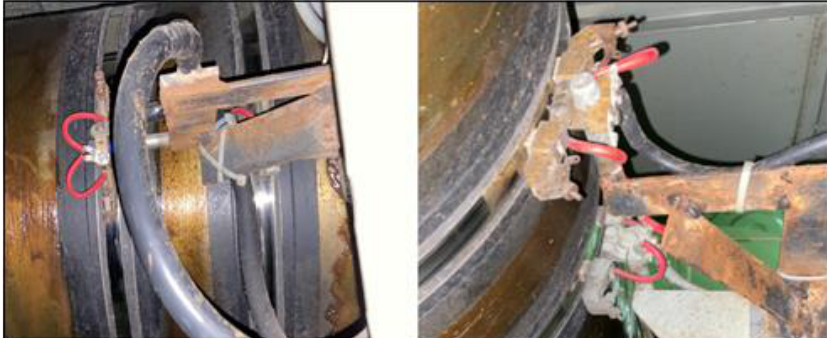
Figure 10. Installation of electrical pitting prevention device on the rotating shaft of the commercial vessel.